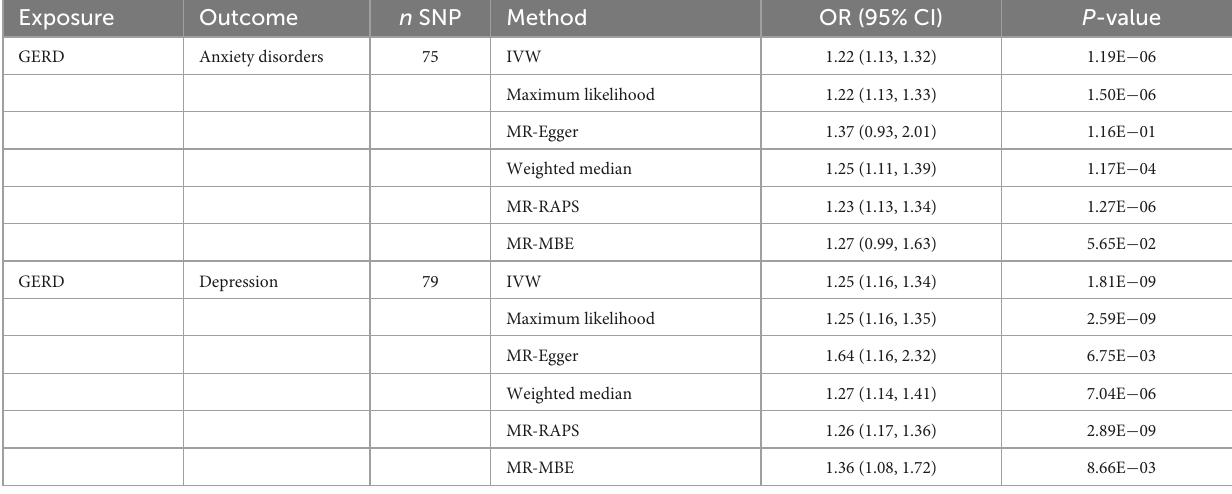
TABLE 6 Results of the causal effect of GERD on anxiety disorders and depression (based on the IVs screened under the locus-wide significance threshold).